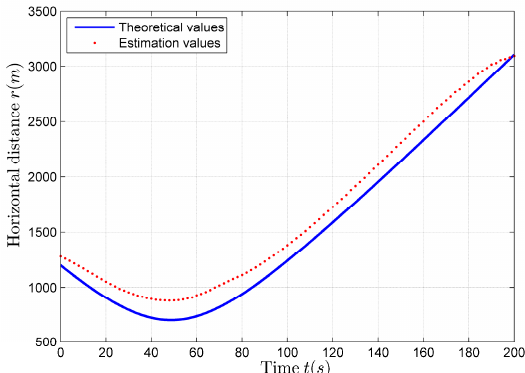
Figure 8. The comparison between the theoretical values and the estimation values of the horizontal distance.